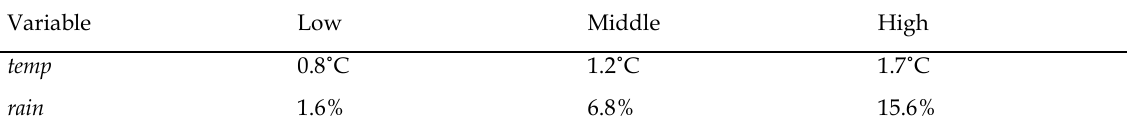
Table 4. Expected change in year average values for weather indicators in the Bodø region by 2050 compared to